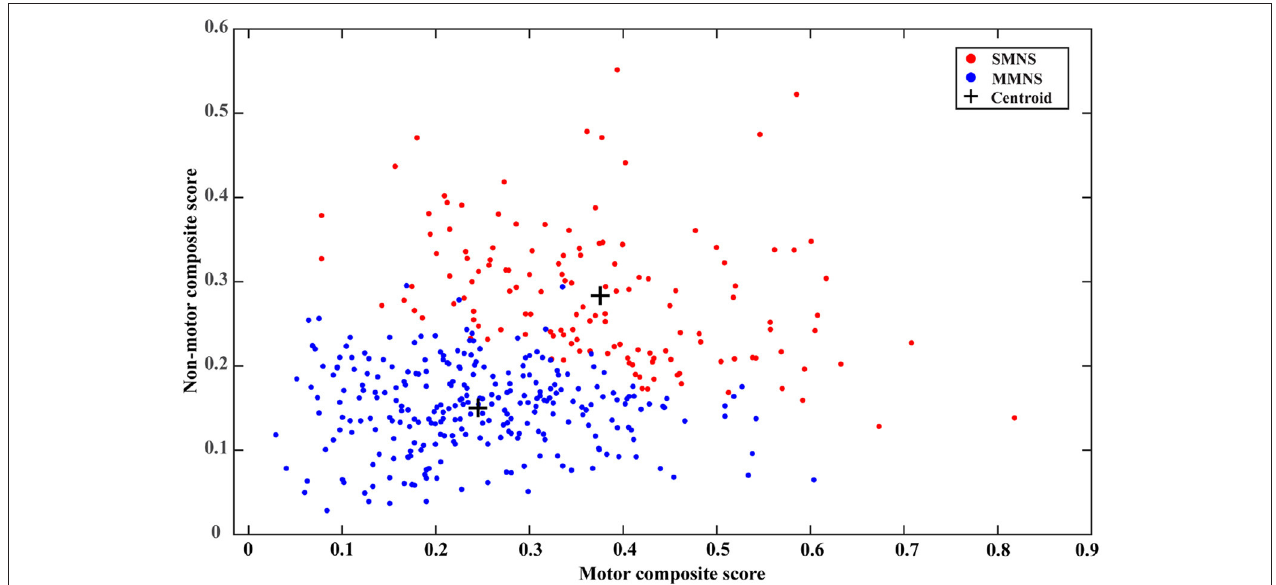
FIGURE 2 | Distribution of cluster memberships in the motor-non-motor plane.